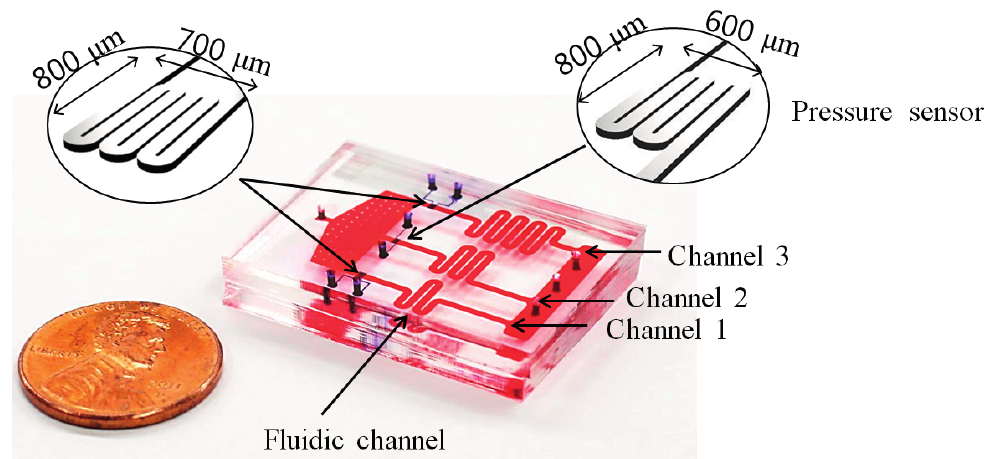
Figure 1. Schematic of the device. The pressure sensor integrated in the microfluidic device consists of three PDMS layers: sensor, thin-film, and fluidic-channel layers. The sensor channel is filled with